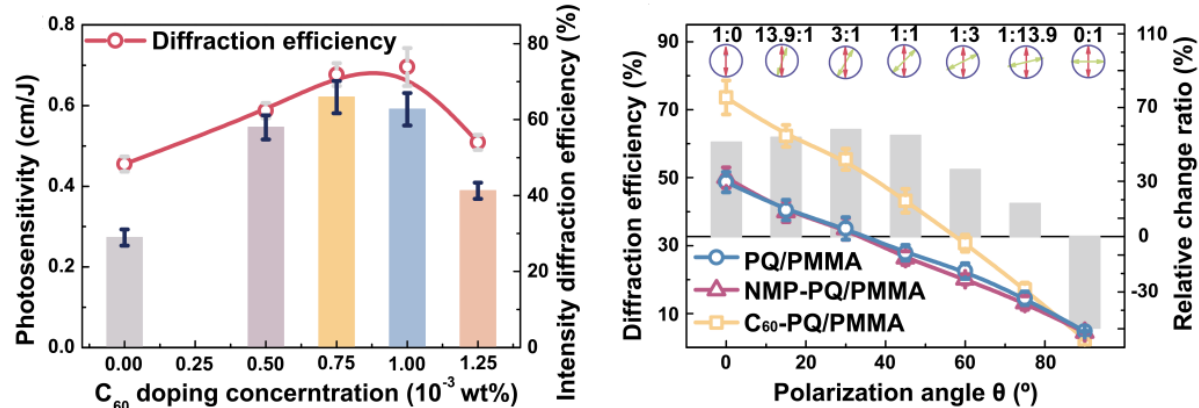
Figure 17. Properties of C 60 - doped PQ/PMMA holography [46] .